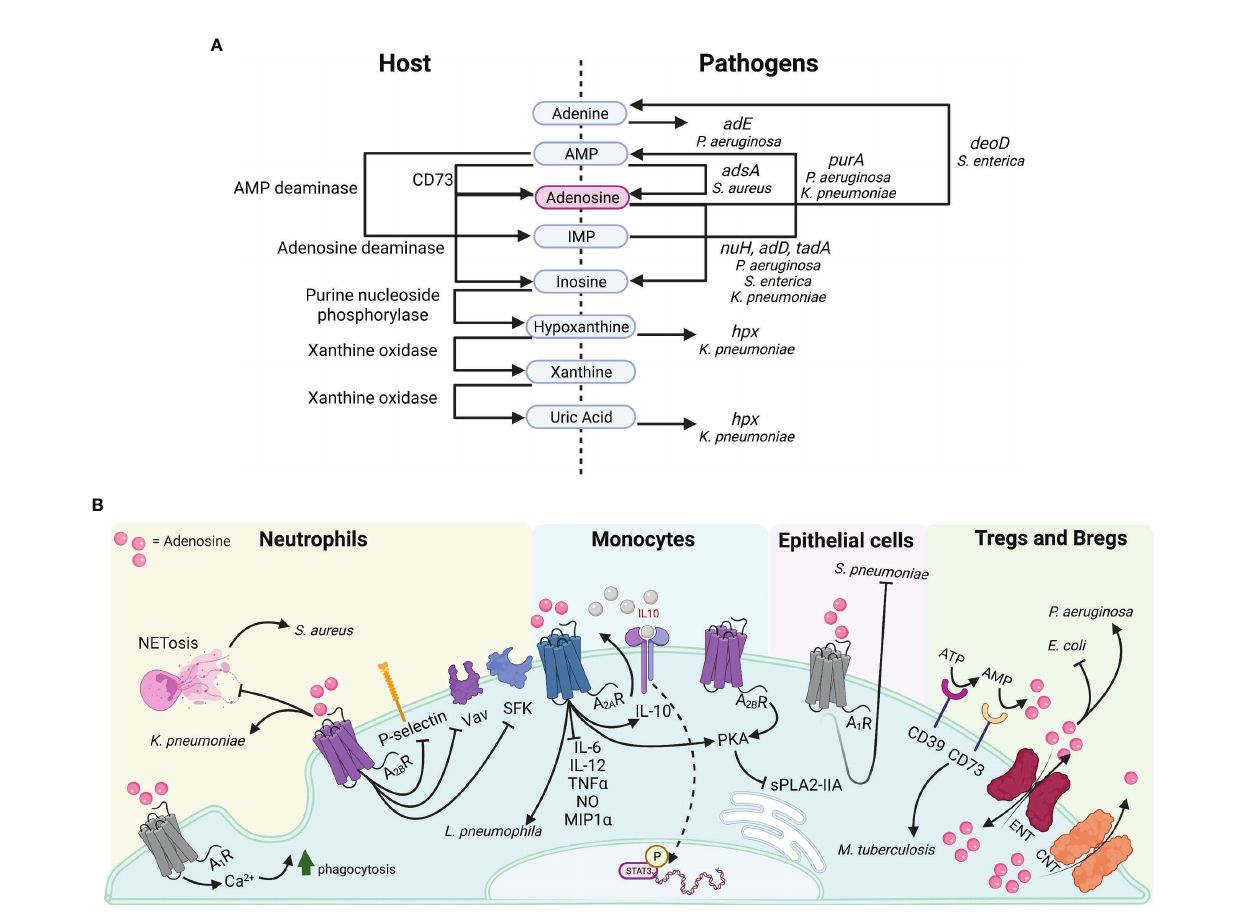
FIGURE 1 | Purine metabolism and adenosine signaling in bacterial pathogenesis. (A) Host proteins (left) and pathogen genes (right) illustrating the synthesis or catabolism of purinergic compounds. (B) Adenosine targets diverse receptors on multiple cell